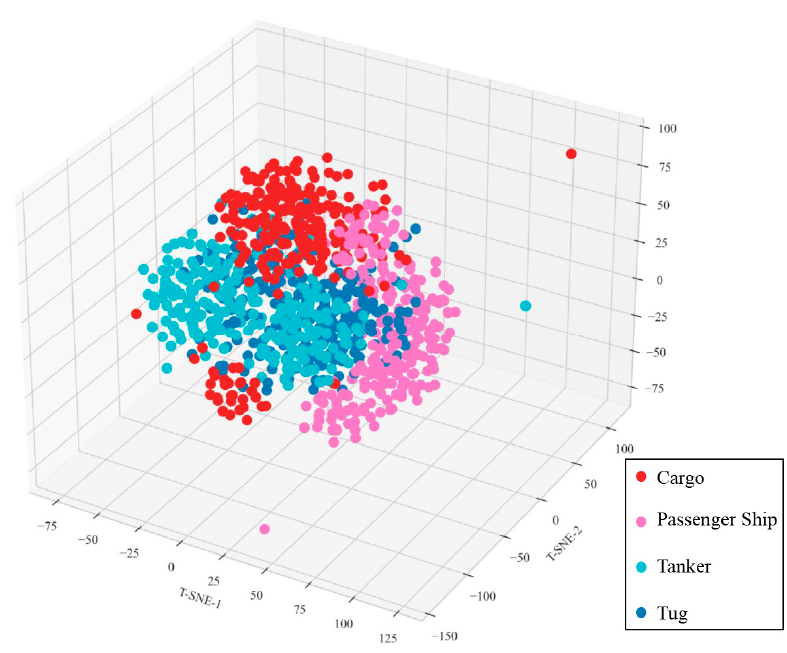
Figure 12. Multi ‐ scale features 3D display by using T ‐ SNE.